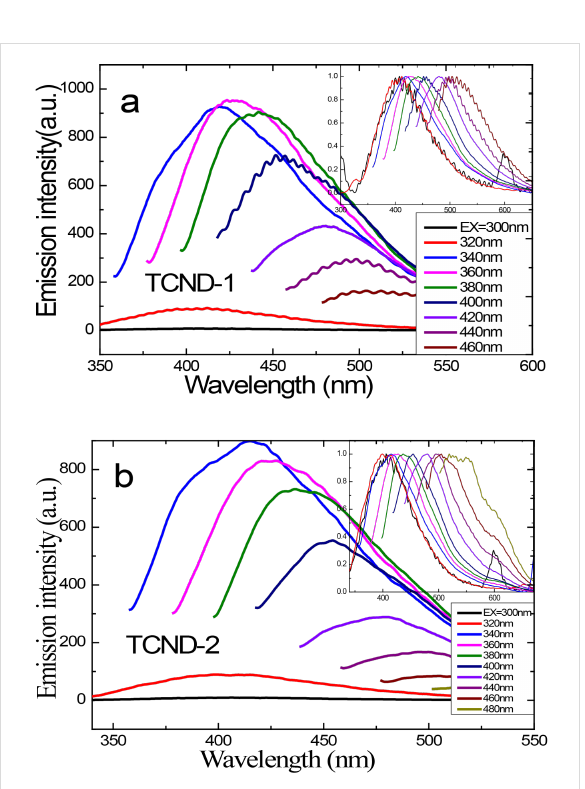
Figure 5: 13 C NMR spectrum of TCND-1 in DMSO- d 6